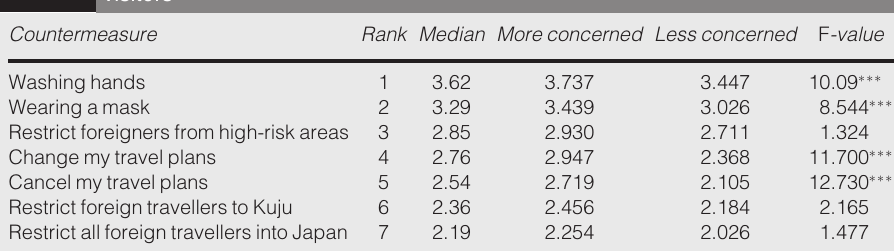
Table 2 ANOVA in agreement with seven countermeasures by more and less concerned